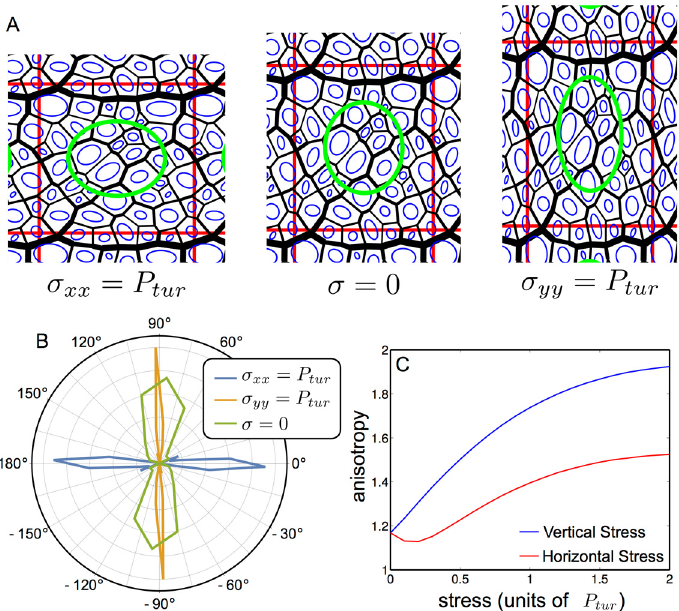
Fig 2. Numerical simulations of a growing network: Anistropy depends on the applied stress. (A) The effect of external stress. Each vein is represented by a black line. The red box is the unit cell with periodic boundary conditions. For visualization, the texture tensor of each areole is shown in the middle of the areole (blue, not to scale), and the averaged texture tensor in the middle of each figure (green, not to scale). The three tissues grew under turgor pressure; in addition, the stress σ xx along the x direction or σ yy along the y direction were set equal to the magnitude of turgor pressure P tur . (B) The distribution of the main orientation (the orientation of the eigenvector associated with the highest eigenvalue) of the texture tensor in the simulation. The distribution is seen to be relatively widely scattered around 90° when no external stress is present (green). When stress is applied, the distribution becomes sharply concentrated around the direction of the external stress (orange and blue). (C) The anisotropy of the texture tensor field averaged over 40 simulations, as a function of the external stress. The stress is measured in units of the turgor pressure, and the anisotropy is measured when the network has doubled its area from the end of the vein creation stage (see